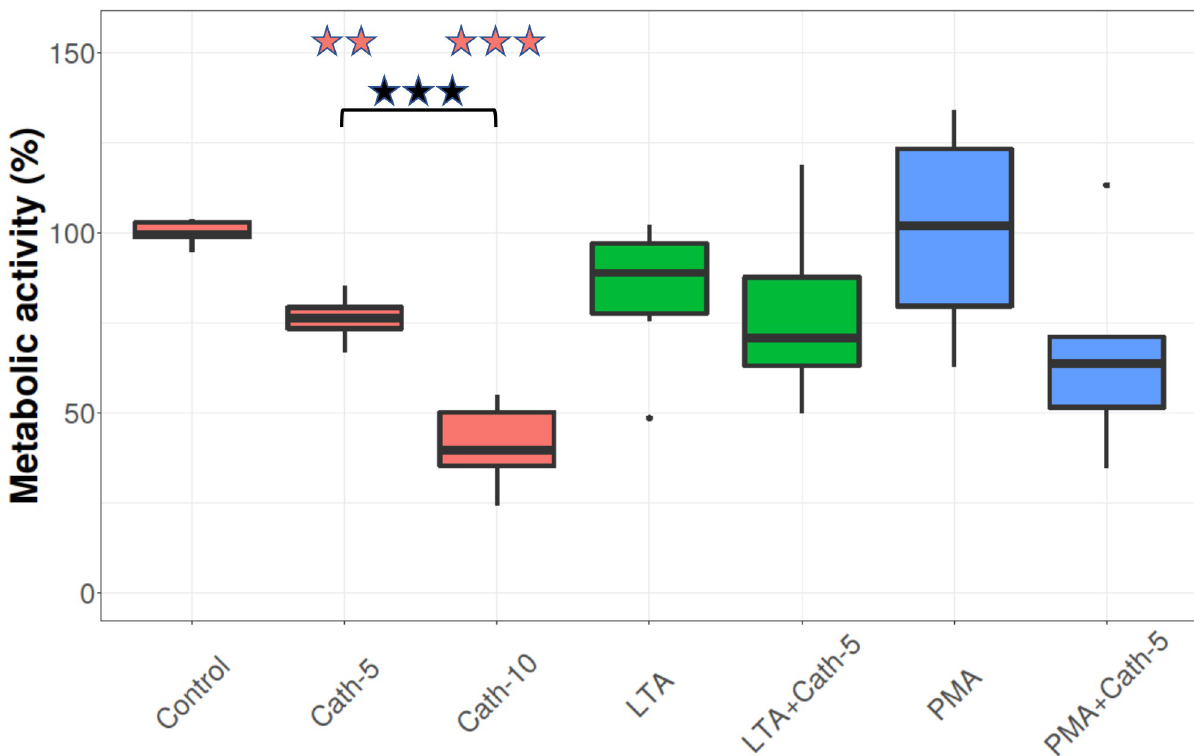
Fig 1. Metabolic activity. Boxplots showing the metabolic activity for hepatocyte–non-parenchymal cell co-cultures treated with chicken cathelicidin- 2 (Cath), lipoteichoic acid (LTA), or phorbol myristate acetate (PMA) only, or the combination of Cath and LTA or PMA (n = 6/group). Results are displayed as percentage, where 100% is the mean value of control cultures. Cath-5 = 5 nmol/mL Cath, Cath-10 = 10 nmol/mL Cath, LTA = 50 μ g/mL Staphylococcus aureus LTA, PMA = 1000 ng/mL PMA. The Control refers to absolute control cells that received none of the treatments. Red asterisks over the boxes refer to significant differences compared to control cells, green asterisks to the group treated only with LTA, blue asterisks to the group treated only with PMA, and black asterisks between the two concentrations of Cath. �� p < 0.01, ��� p < 0.001.